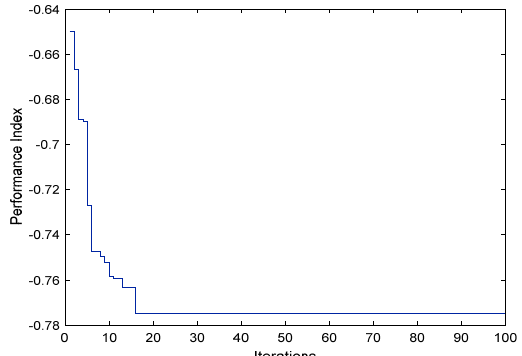
Figure 4. Evaluation of performance index with the number of iterations